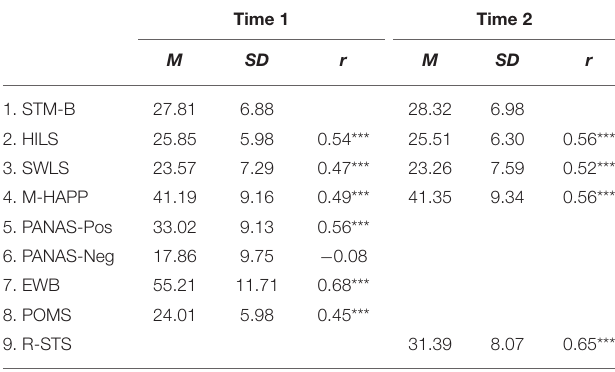
TABLE 2 | Means, SDs, and Pearson correlation coefficients of the STM-B and measures of well-being at Time 1 ( N = 223) and Time 2 ( N =